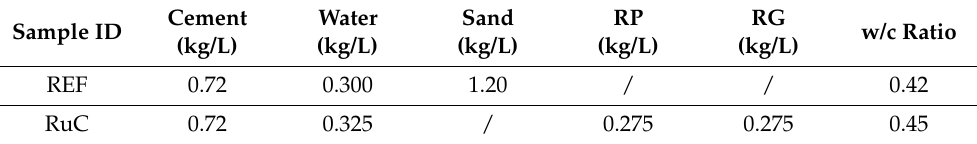
Table 3. Concrete mix proportions.